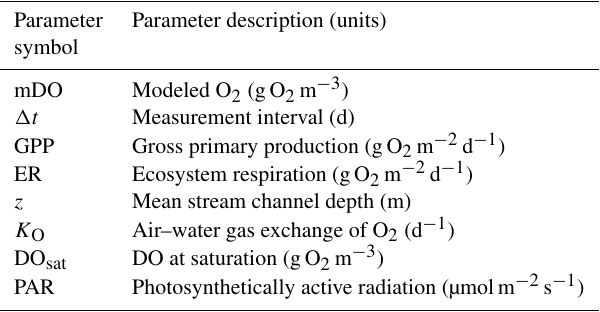
Table 1. Parameter symbols, descriptions, and units used in Eq.